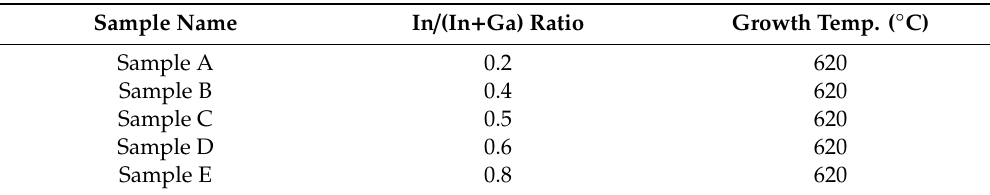
The growth parameters for sample series I as a function of flux ratio at N flux BEP = 9.0 × 10 − 6 torr.